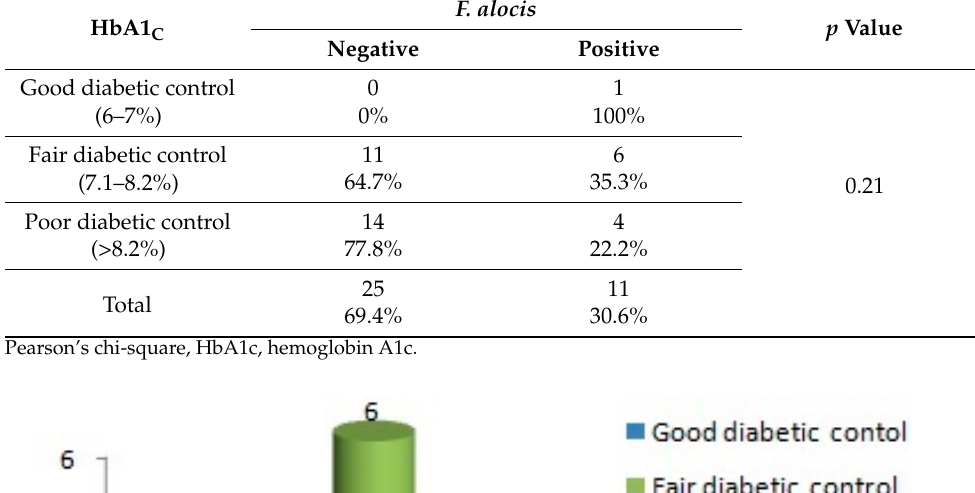
Table 5. Correlation of HbA1c values with the presence or absence of F. alocis . HbA1 C